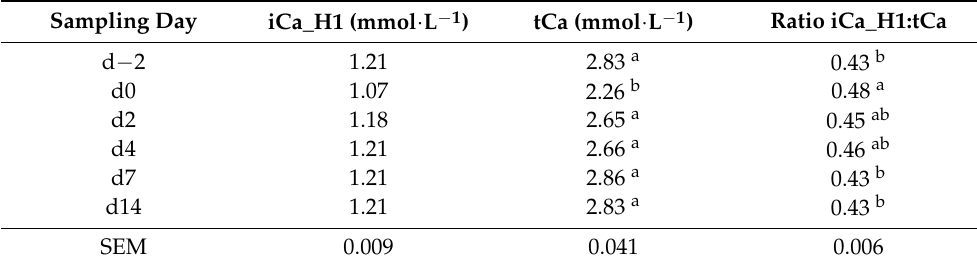
Table 3. Time- and method-dependent changes in ionized calcium measured from heparinized vacutainer (iCa_H1), total serum calcium (tCa) and the resulting ratio iCa_H1:tCa.